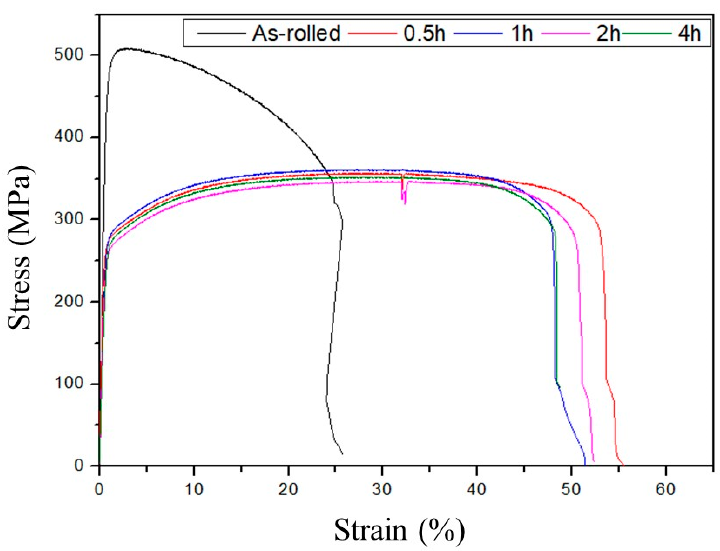
Figure 5. Stress–strain responses of as-roll-bonded clad metals annealed at 450 °C for different times. Table 2. Tensile properties of base metals (Ti and Cu), as-rolled titanium clad, and annealed titanium clad.